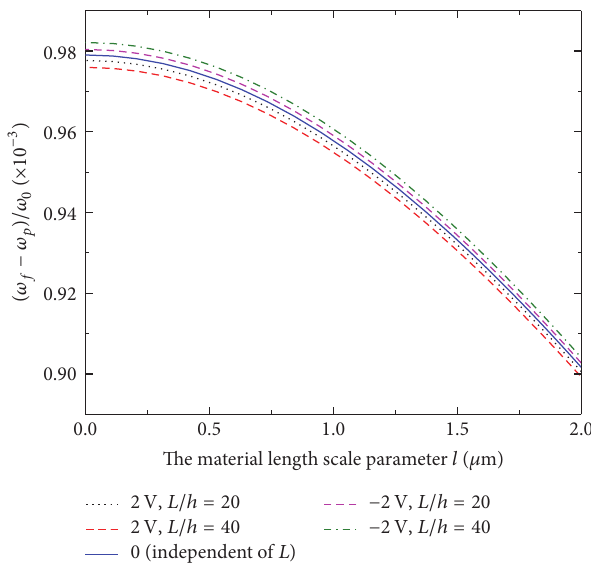
Figure 5: 𝑙 -dependence of (𝜔 𝑓 − 𝜔 𝑝 )/𝜔 0 obtained for PMBs where ℎ is fixed at 10 𝜇 m and 𝐿/ℎ is equal to 20 and 40,